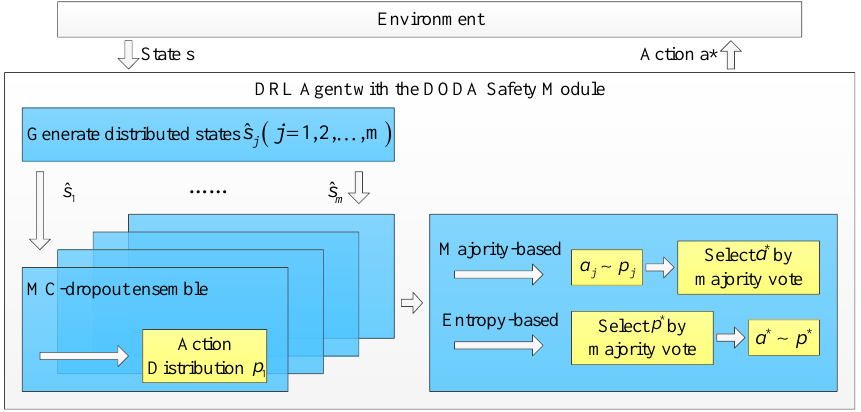
Figure 14. Structure of the DODA safety module. Reprint with permission from [30]. 2021, Peng.